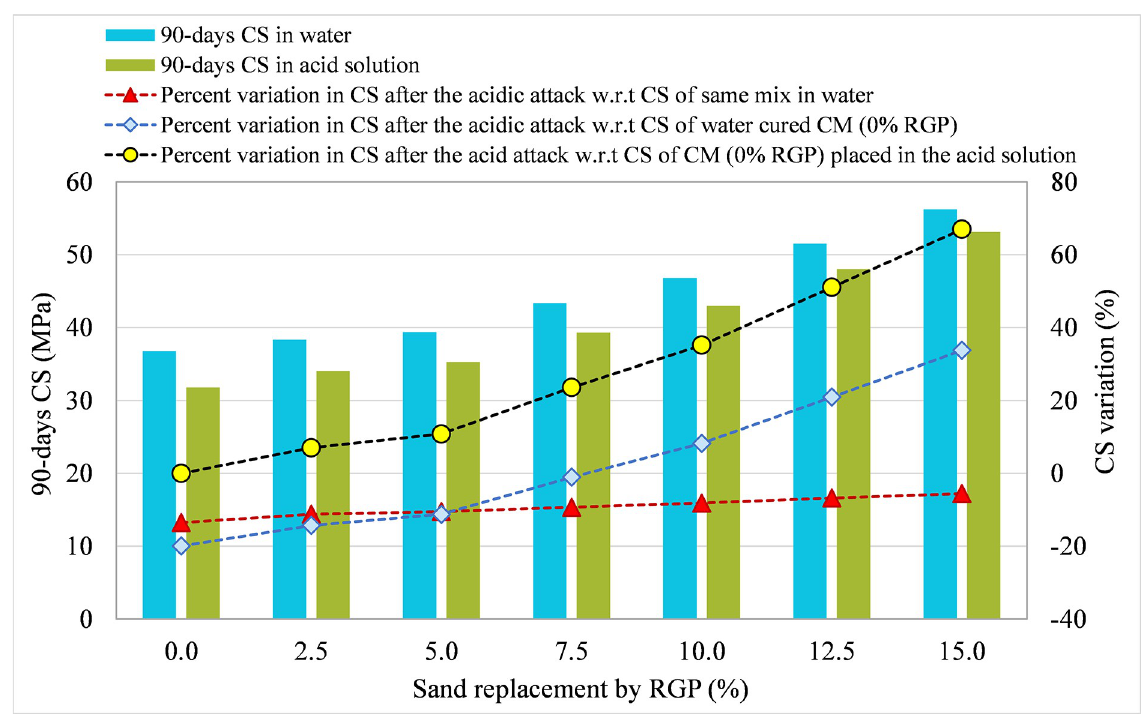
Fig 13. CS variation in samples placed in plain water and the acid solution for SF-15 mix incorporating RGP as a sand replacement.